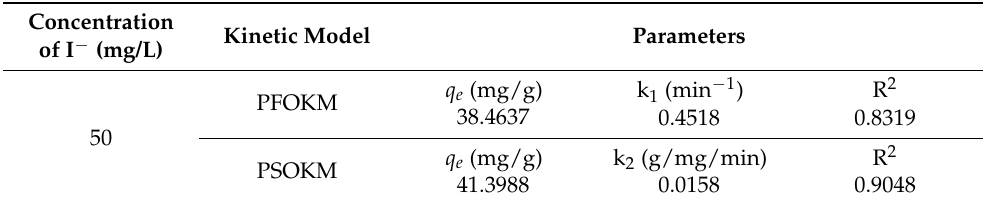
Figure 12. Kinetic adsorption of I − on the mag@silica-Ag composite. Adsorbent 0.01 g, I − solution 10 mL. Table 6. Kinetic adsorption parameters obtained using PFOKM and PSOKM on the mag@silica-Ag composite at 50 ppm of I − .